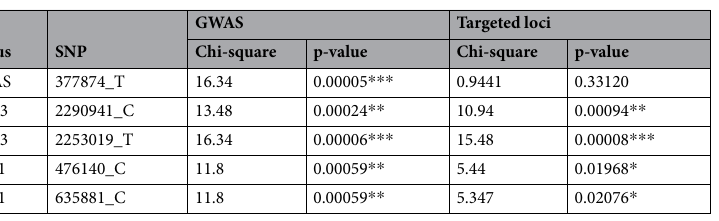
Table 2. Results from association analysis in targeted SNPs (N = 27) as compared to results obtained from genome-wide association (N = 13). * Significant at 0.05; ** Significant at 0.001; *** Significant at 0.0001. See Supplementary Material, Table S1 for a full distribution of genotypes for cases and